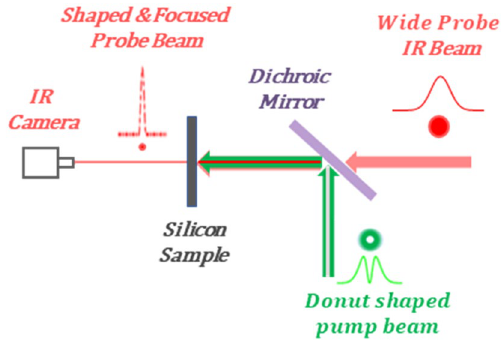
Figure 1. The concept of IR beam focusing inside the silicon. A donut shaped pump laser pulse is absorbed in the silicon and induces, temporally, a donut shape FCCs area with the same size, in the silicon. A second IR probe laser pulse that is lunched right after, is being blocked by the FCCs donut area via FCCs absorption. The center of the IR beam is transmitted and focused to a narrow beam via FCCs dispersion.